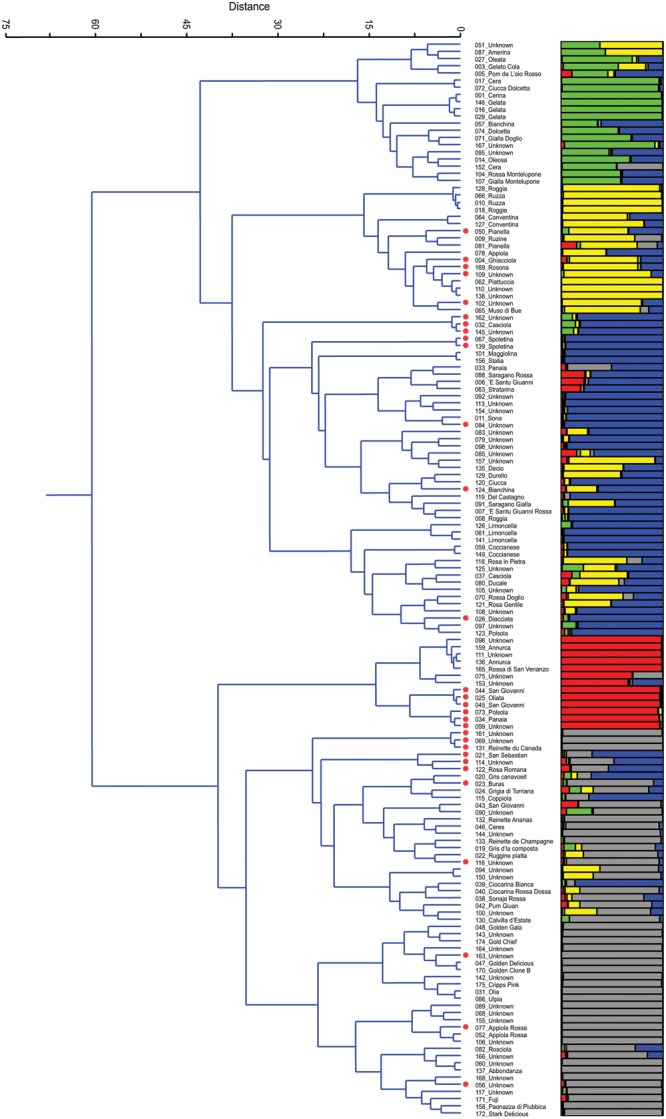
Ward’s clustering dendrogram of the 150 accessions of apple (on the left) and assignment by STRUCTURE at K = 5 (on the right). Polyploids are red labelled beside the accession name.